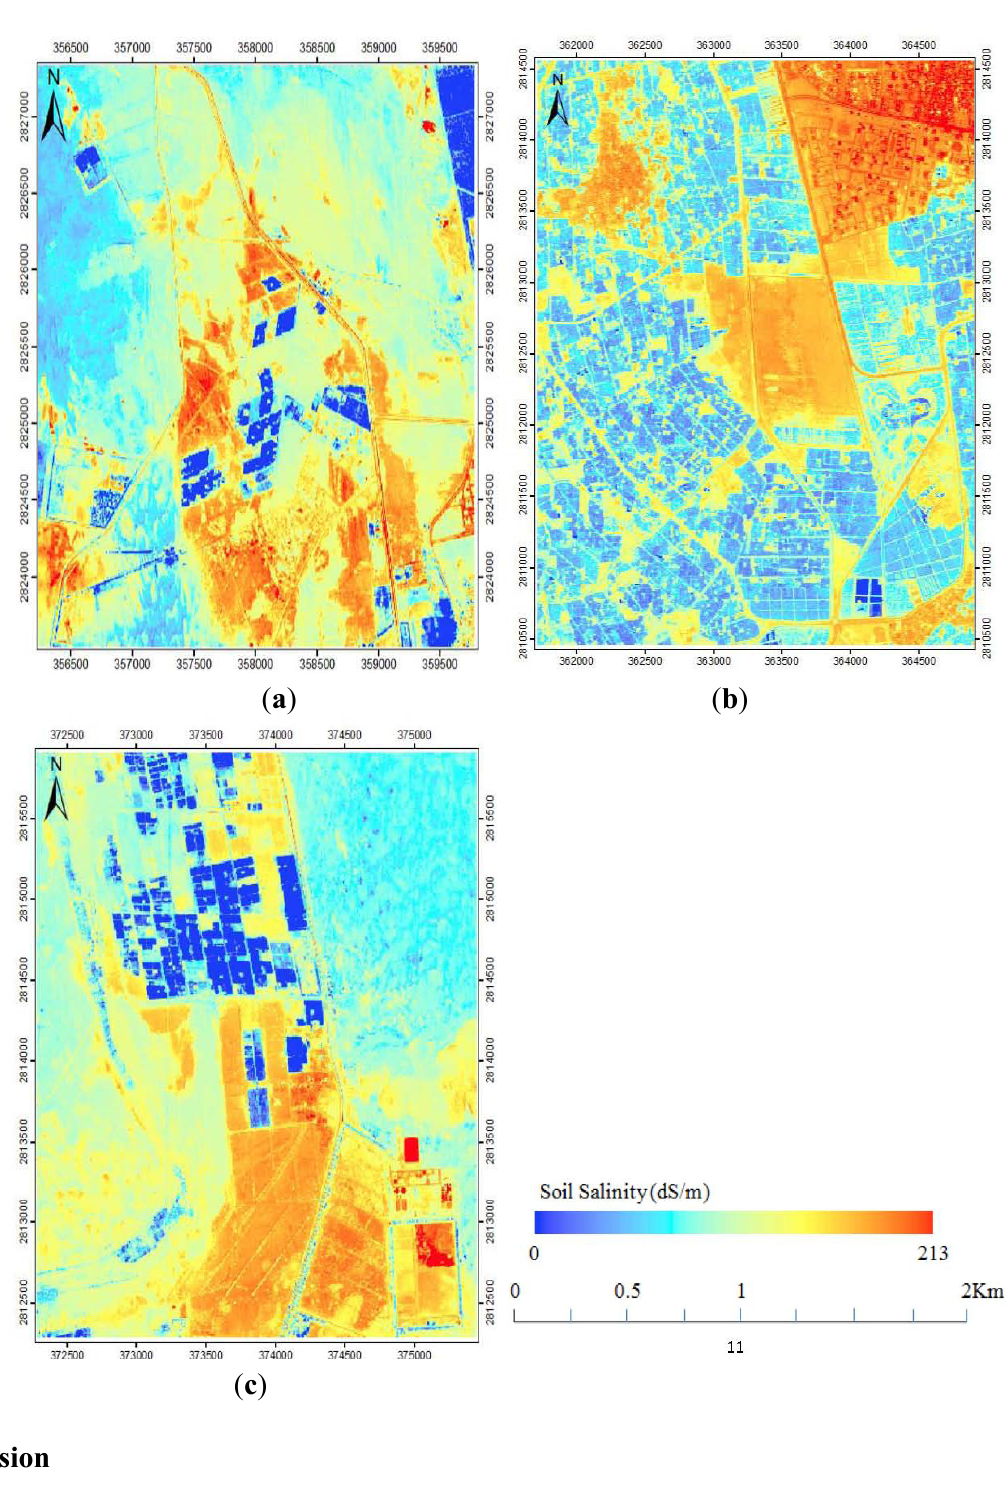
Figure 4. Soil salinity maps for different sites in the study region: ( a ) site one; ( b ) site two; and ( c ) site